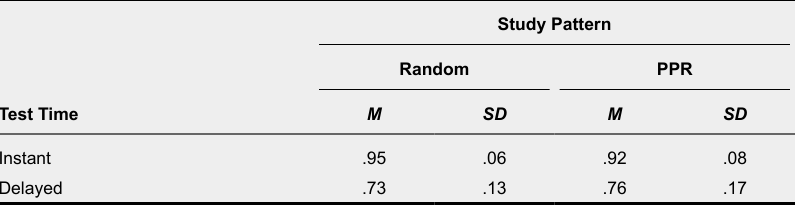
Mean (and SD) Recall Accuracy—Proportion Correct—for Participants Studying Random or Previous Participants’ Recall Data (PPR) Tested Either Instantly or